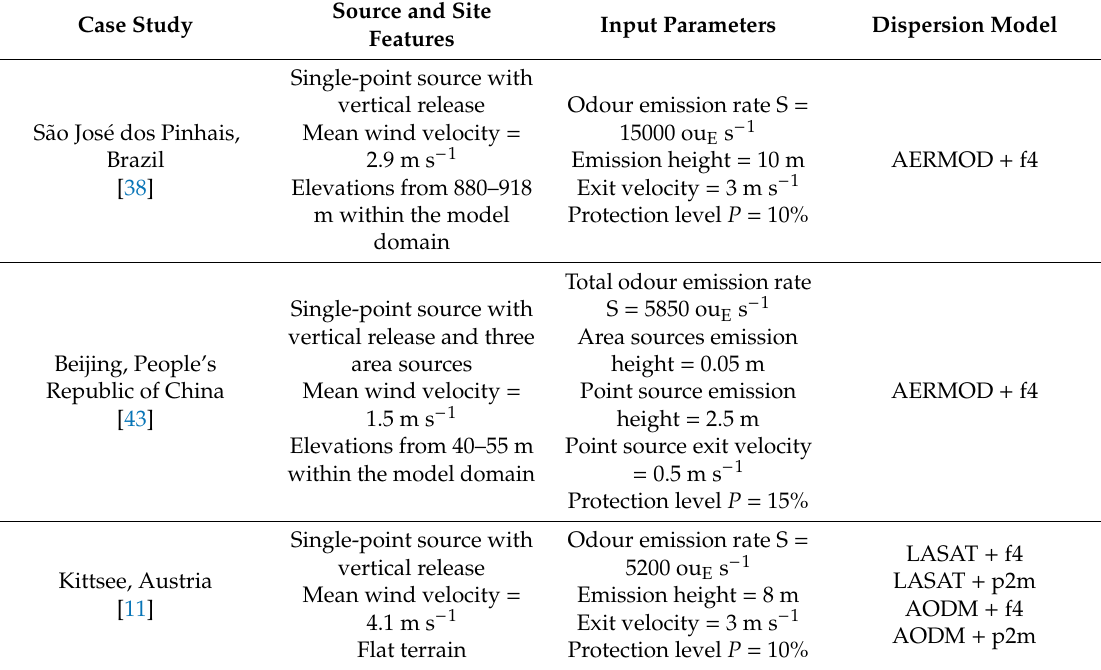
Table 2. Summary of source and site features and input parameters of the three selected case studies in S ã o Jos é dos Pinhais, Brazil; Beijing, People’s Republic of China, and Kittsee, Austria, for the selected EQs and dispersion